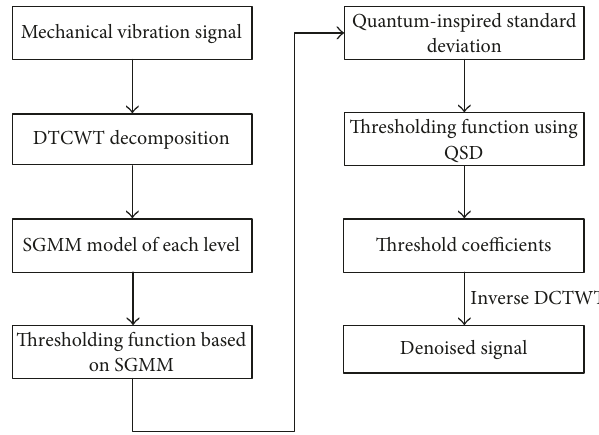
Figure 1: Flow chart of the proposed denoising algorithm. −2−1.5−1−0.500.511.52